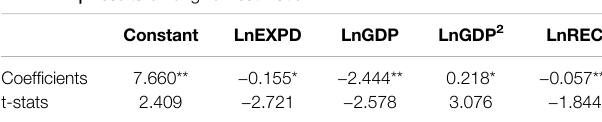
TABLE 4 | Results of long-run